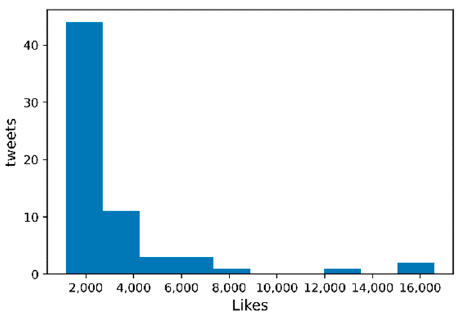
Figure 6. Buzz tweet like distribution.